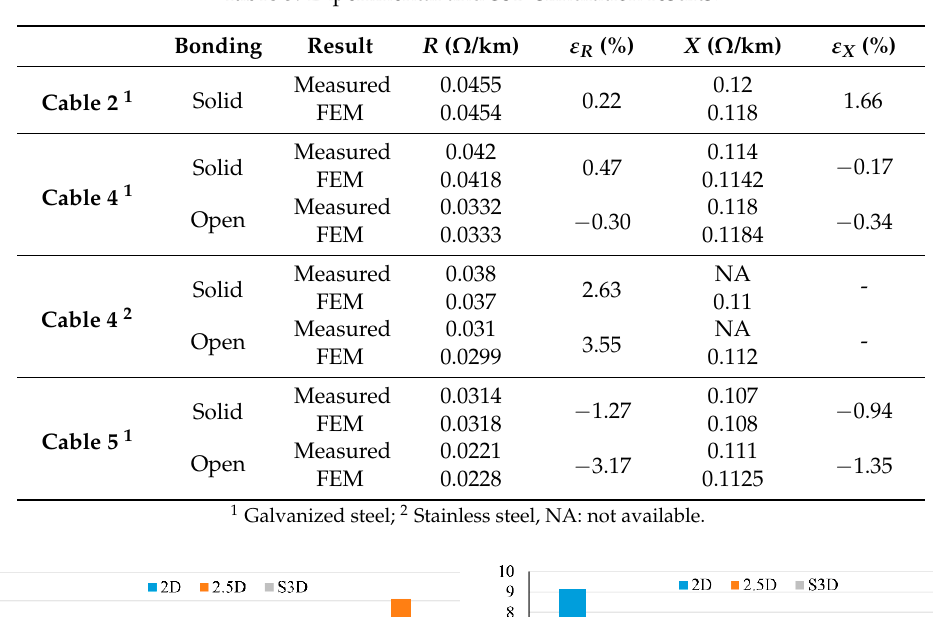
Table 5. Experimental and S3D simulation results.